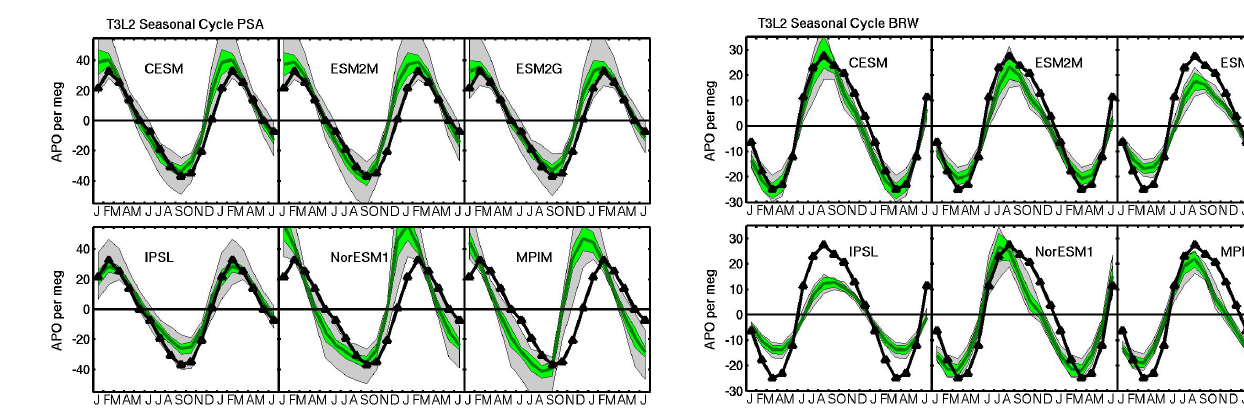
Figure 2b. Results at Palmer Station (64.9 ◦ S, 64 ◦ W), compared to SIO observations.